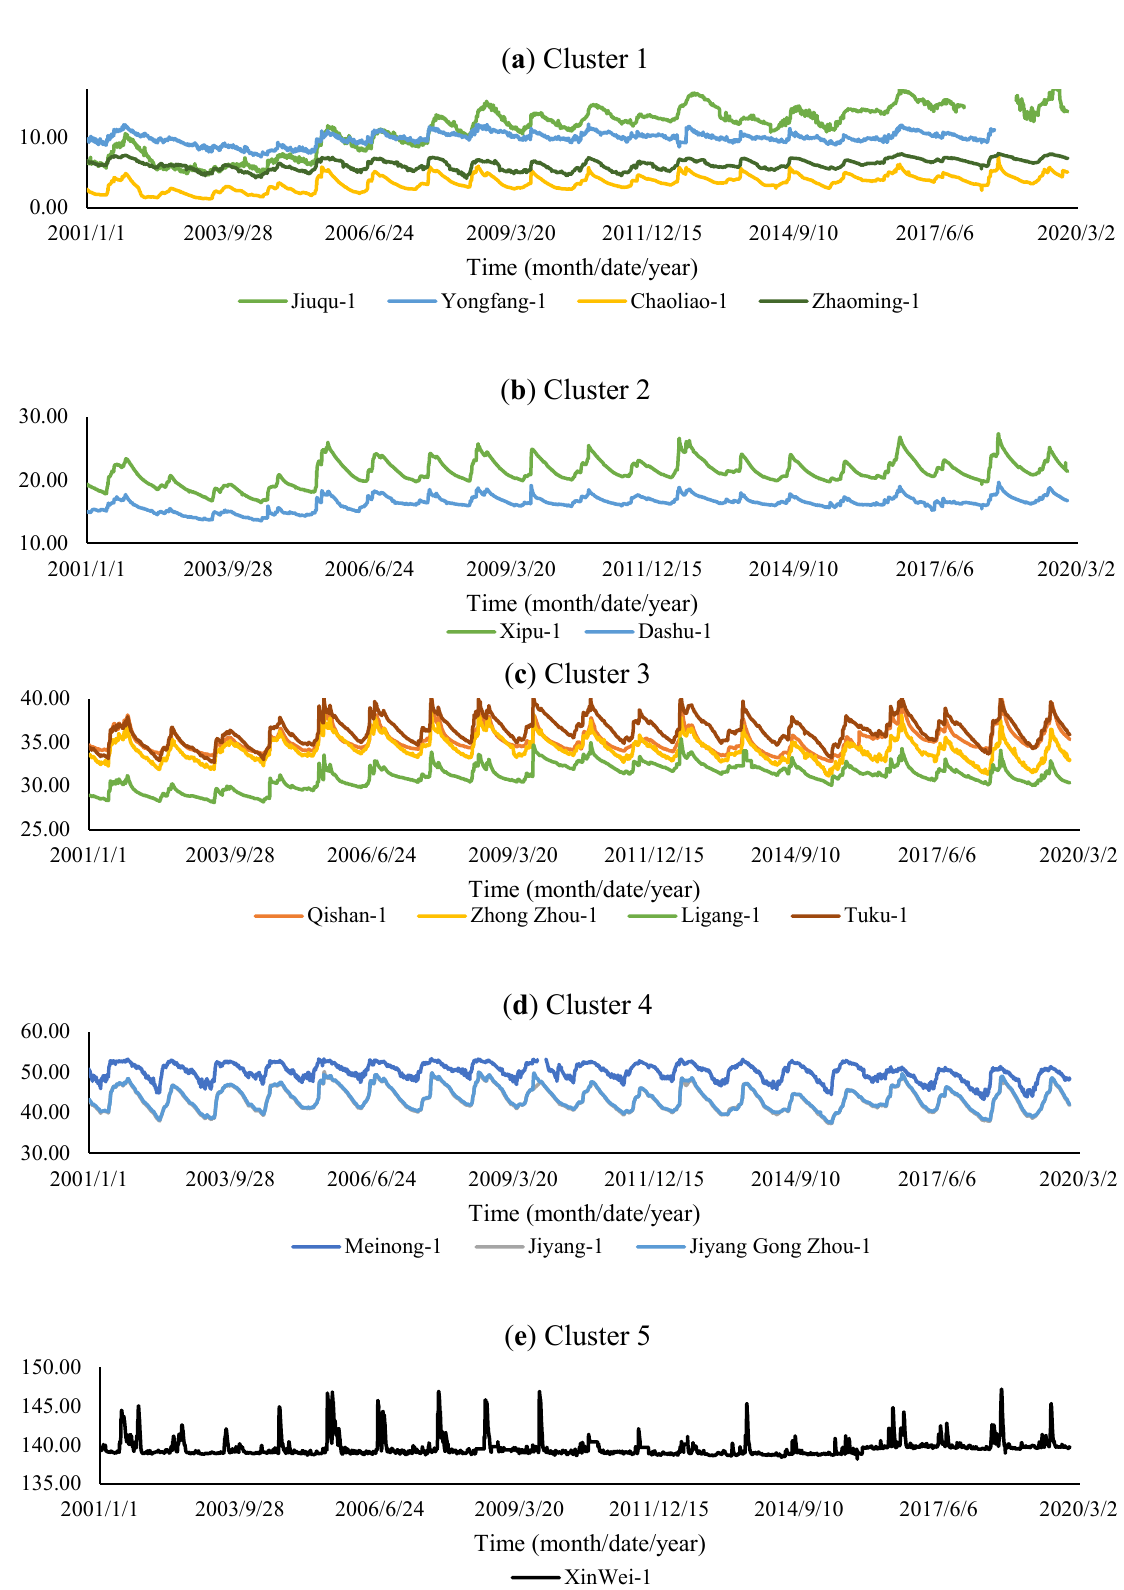
Figure 8. The original time series groundwater hydrograph of different groups of aquifer 1 observation wells based on the classification of Hierarchical Clustering Analysis. There are five clusters ( a ) Cluster 1 consist of Juiqu, Yongfang, Chaoliao and Zhaoming observation wells ( b ) Cluster 2 comprised of Xipu and Dashu ( c ) Cluster 3 contains Qishan, Zhongzhou, Ligang and Tuku ( d ) Cluster 4 covers Meinong, Jiyang and Jiyang Gongzhou while ( e ) Cluster 5 consist of Xinwei only